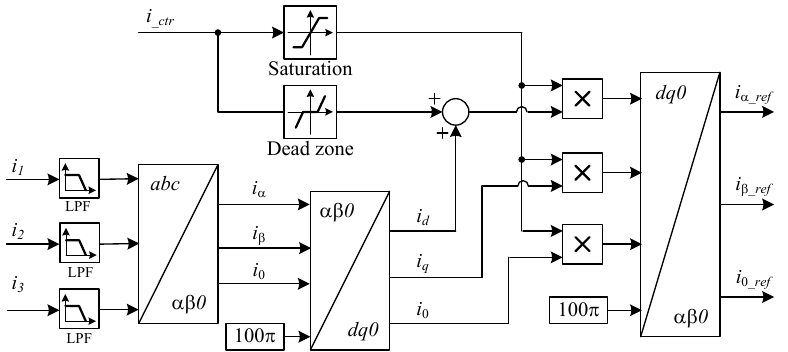
Figure 8. Scheme for the generation of the inverter current references for the imbalance associated with the active power imbalance and linear loads.